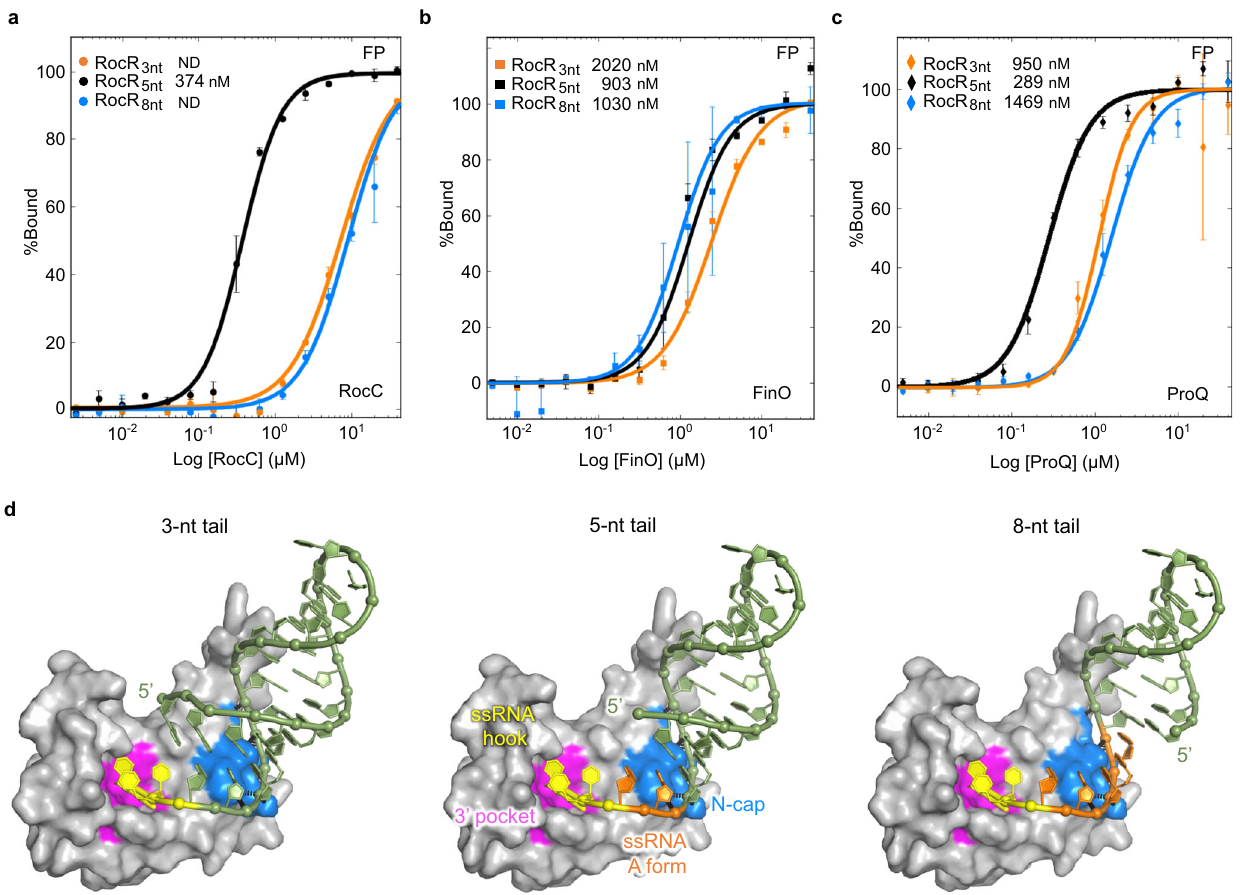
Fig. 5 | Speci fi cities for 3 ’ tail length among FinO domain-containing proteins. a – c FP binding assay for various tail lengths of 5 ’ FAM-labeled RocR SL3 with RocC 14-126 ( n =3). a With FinO 45-186 ( b ), or with ProQ 1-130 . ND indicates mutants where RNA binding was too weak to determine a K D . ND indicates mutants where RNA binding could not be detected. The error bars are the